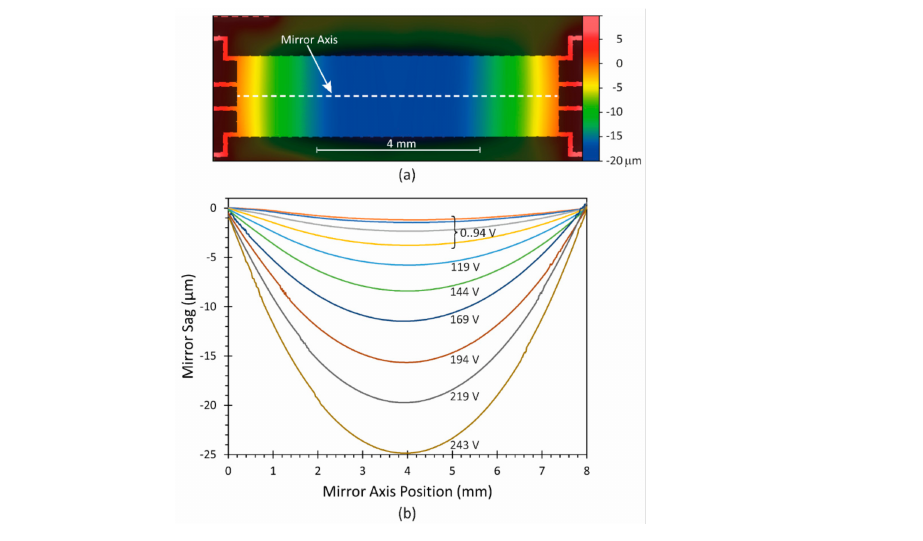
Figure 5. Measured deformations of the MAAM mirror for varying applied voltages: ( a ) deformation of the mirror surface and suspending structure for a membrane voltage of 219 V; ( b ) derived mirror sag measurements along the long mirror axis for voltages applied to the MAAM from 0 V to 243